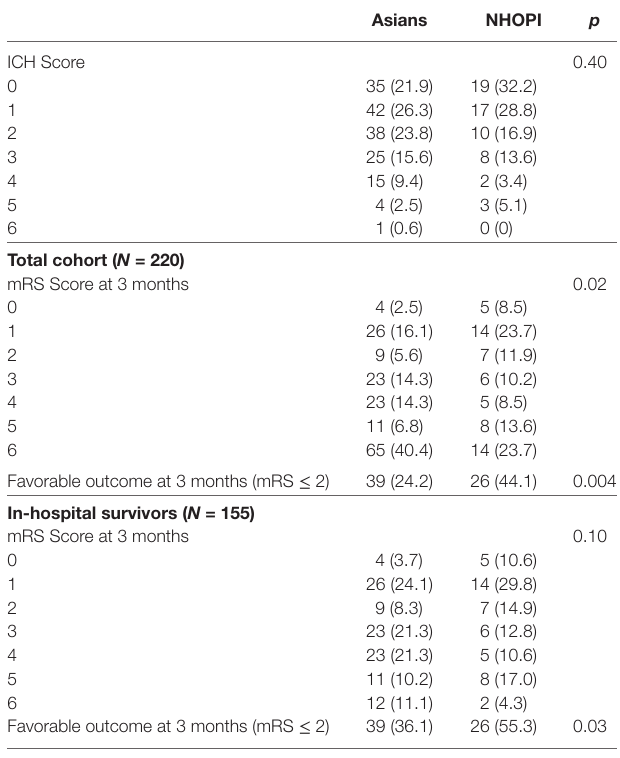
TaBle 2 | Comparison of ICH severity and outcome between Asians and